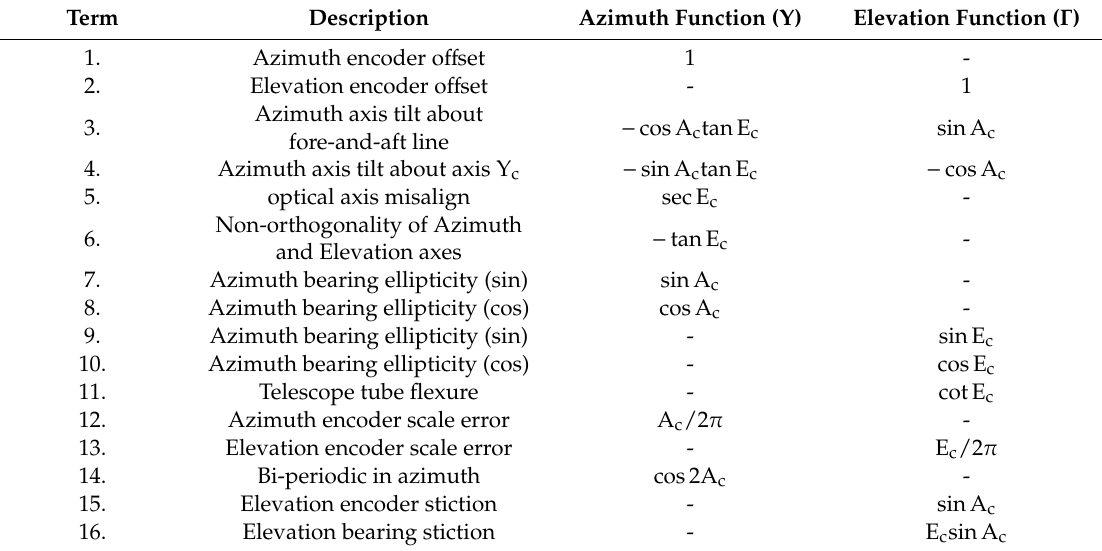
Table 2. The ATP mount